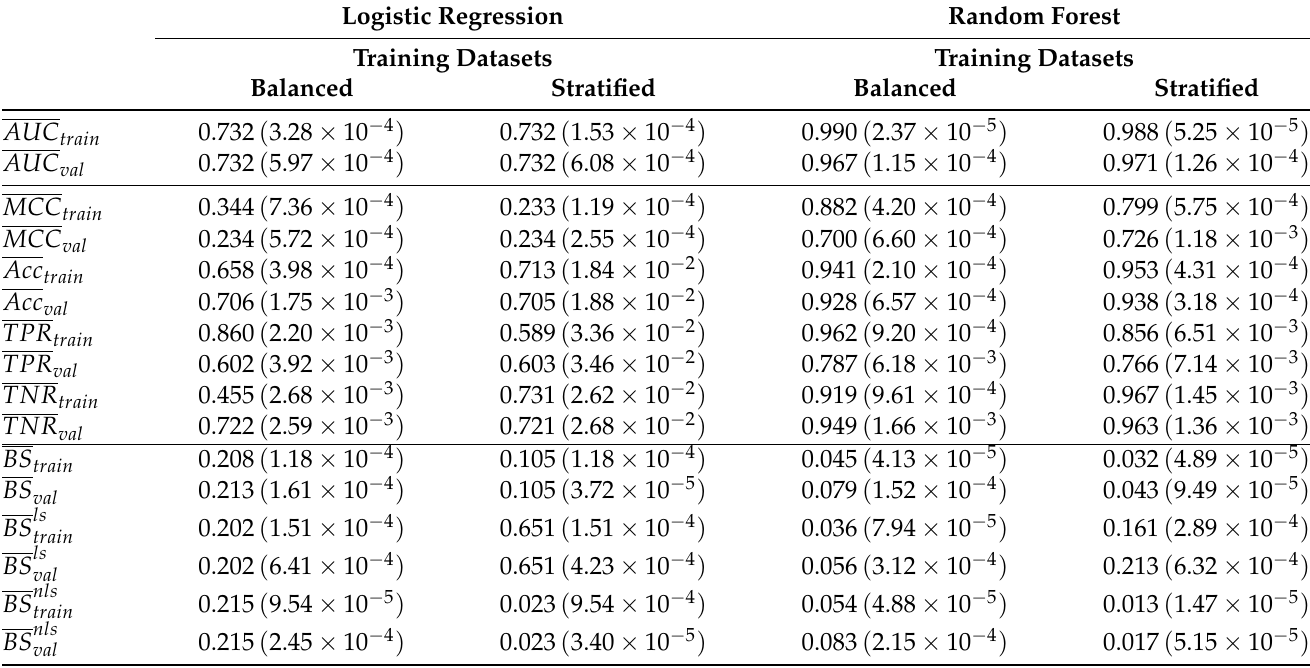
Table 4. Average values of metrics based on classification performance of ( AUC , MCC , Acc , TPR , and TNR ) and calibration of probabilities ( BS ) by logistic regression and random forest models. Bar indicates the average value of metric and standard deviation is given in parentheses. Note that for BS lower values indicate better